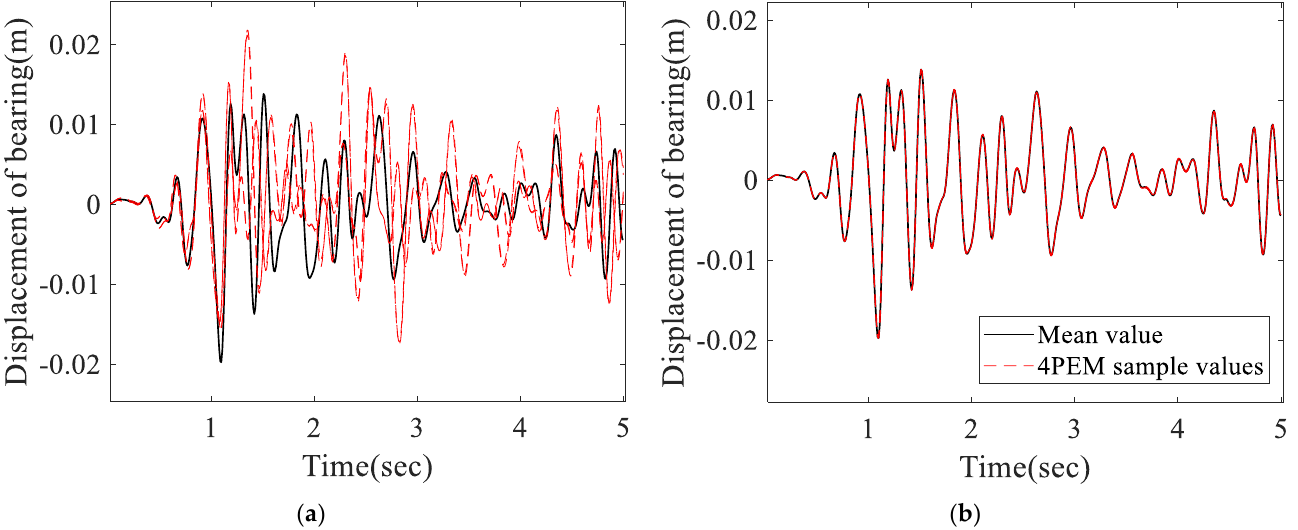
 . Figure 6. Time history of LRB displacement sensitivity performance. ( a ). Sensitivity of K db . ( b ). Sensitivity of ε uc